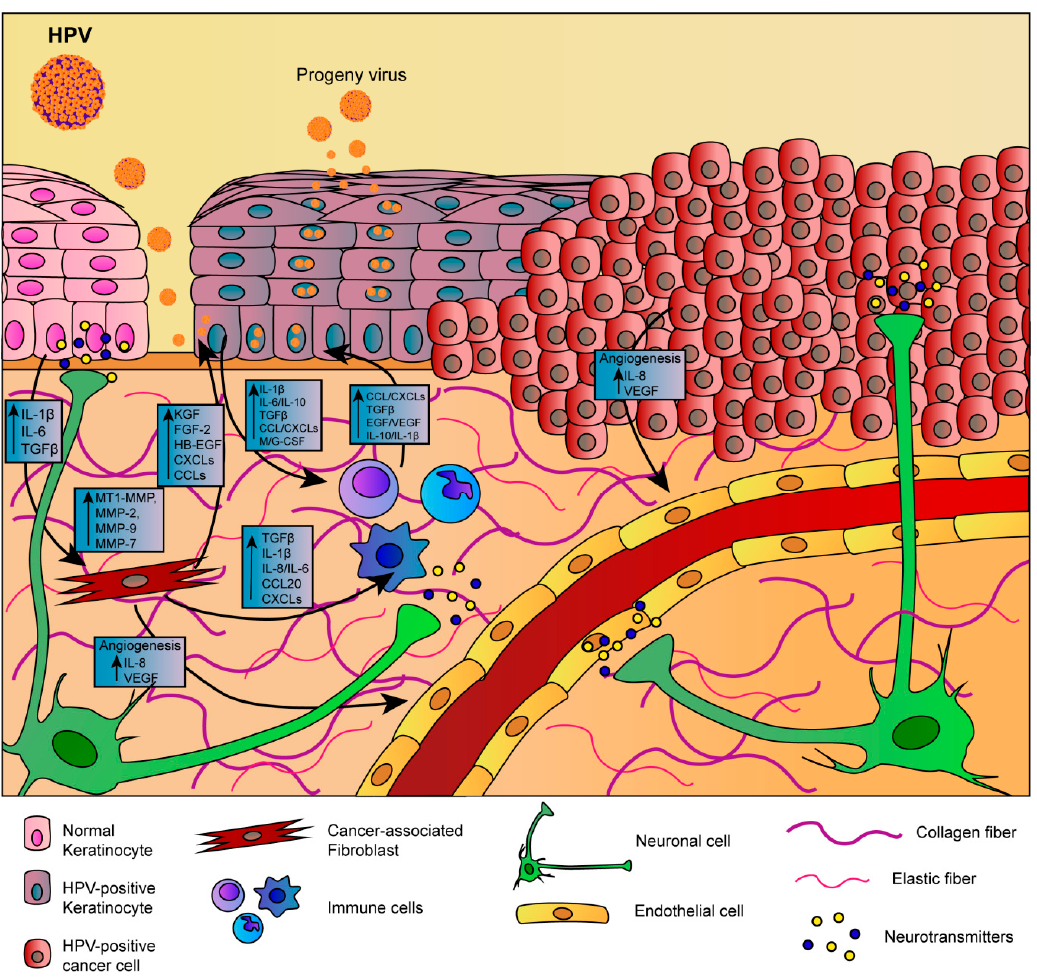
Figure 3. Diagrammatic representation of the bidirectional cross-talk between HPV-positive epithelium and tumor microenvironment (TME). HPV-positive epithelium and stromal cells (CAF, endothelial cells, immune cells and neuronal cells) communicate with HPV-infected epithelium through the exchange of growth factors (TGF- β , VEGF, HB-EGF, EGF), cytokines (IL, CXCLs and CCLs), Neurotransmitters and ECM molecules (MMPs) and other molecules (M-CSF, G-CSF). Large black arrows represent the bidirectional communication between HPV-positive epithelium and stromal cells. Small black arrows in the squares represent an increase (up arrow) of specific factor. CAF = Cancer-Associated Fibroblast; IL= Interleukins; CXCs/CCLs= Chemokines; TGF- β = Transforming Growth Factor-beta; EGF= Epidermal Growth Factor; HB-EGF= Heparin-binding EGF-like growth factor; FGF-2= Fibroblast Growth Factor-2; VEGF= Vascular Endothelial Growth Factor; M-CSF= Macrophage Colony-Stimulating Factor; G-CSF= Granulocyte-Colony Stimulating Factor; MMPs= Metalloproteinases.